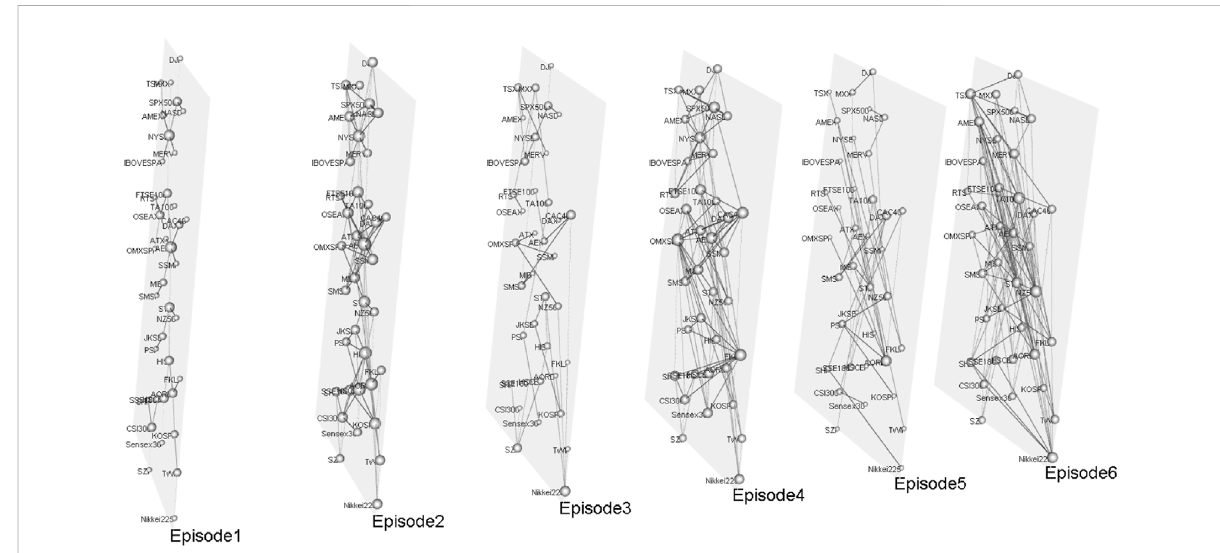
FIGURE 4 (Color online) Multilayer network at the time of global fi nancial crisis.